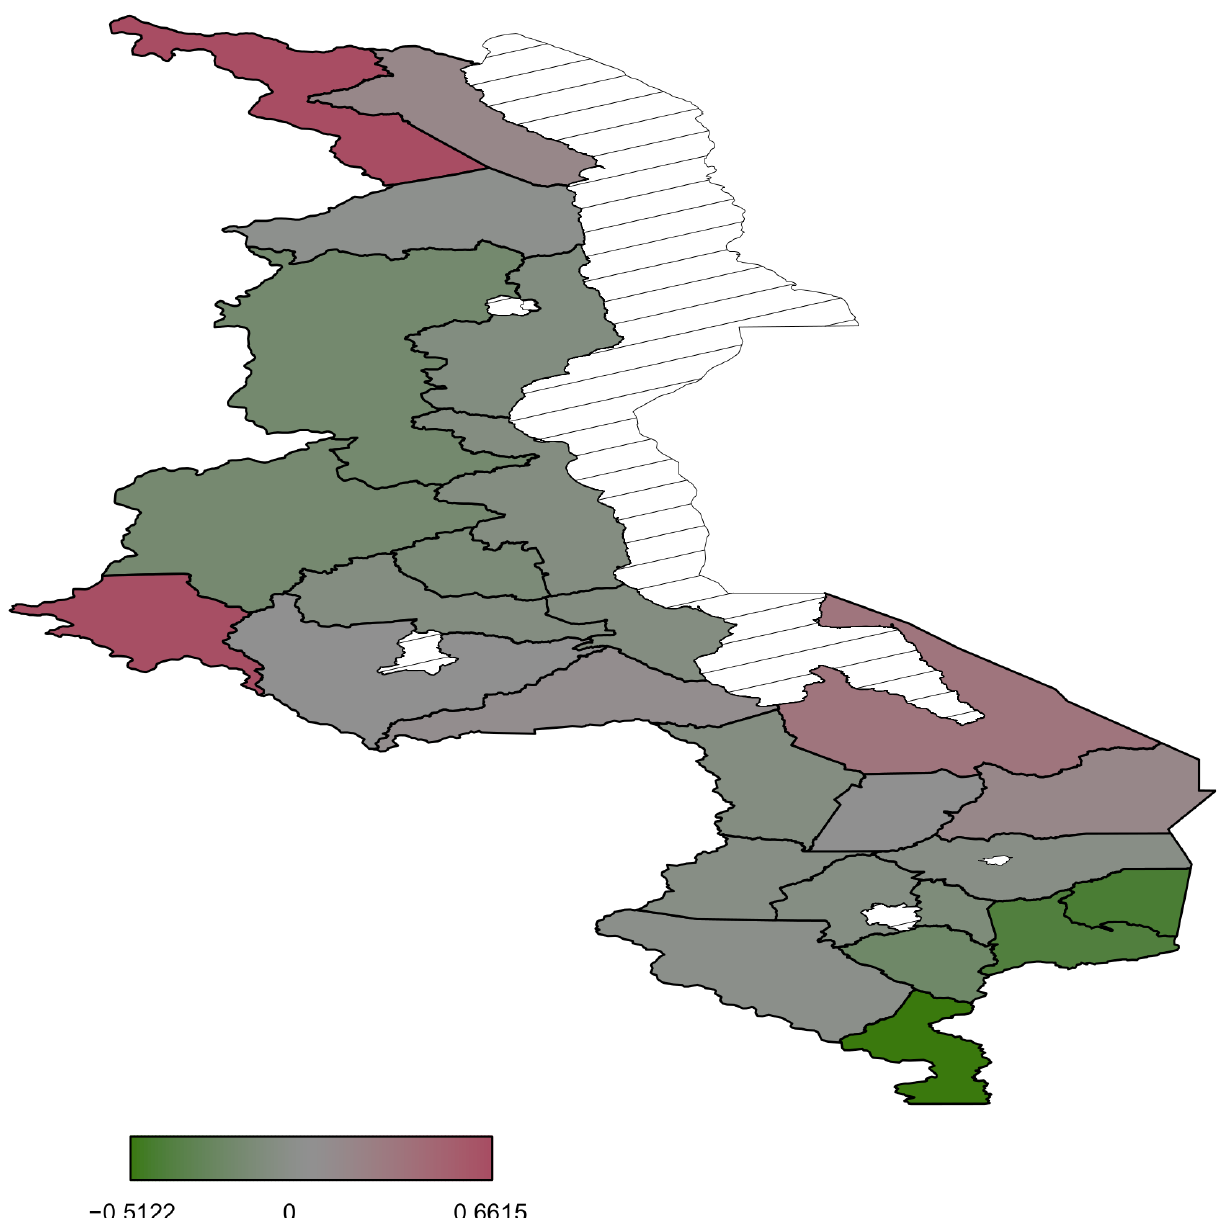
Fig 5. Residual spatial patterns from the logistic